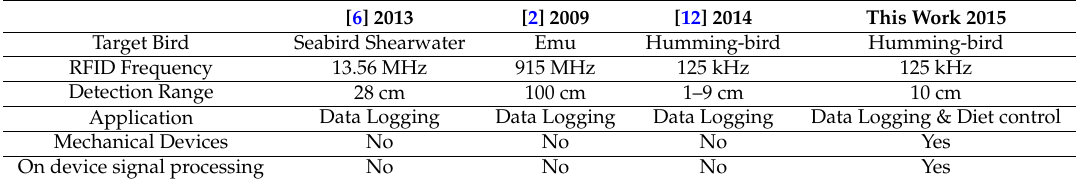
Table 2. Comparison of recently reported RFID based ornithology